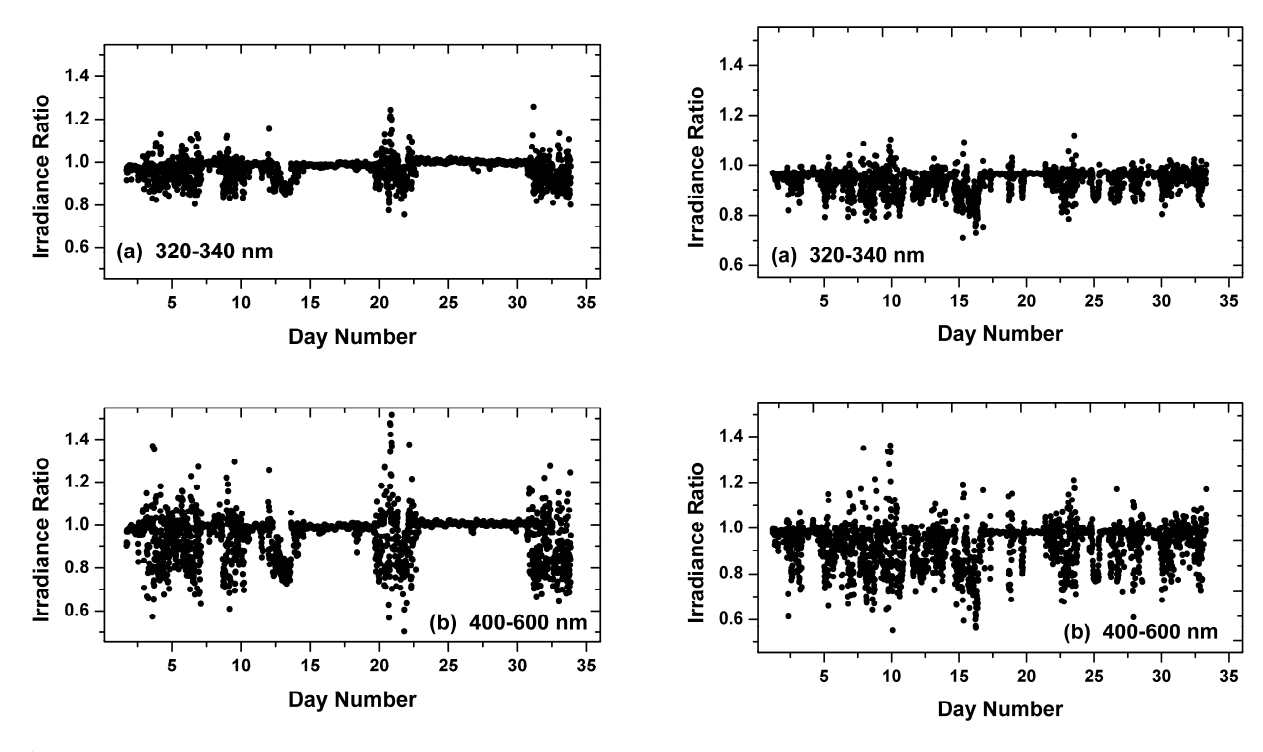
Fig. 4. Irradiance ratios for the solstice period December 2007 to January 2008, a relatively cloudy period: (a) 320–340nm wave- length band. (b) 400–600nm wavelength band. Day number 1 is 7 December